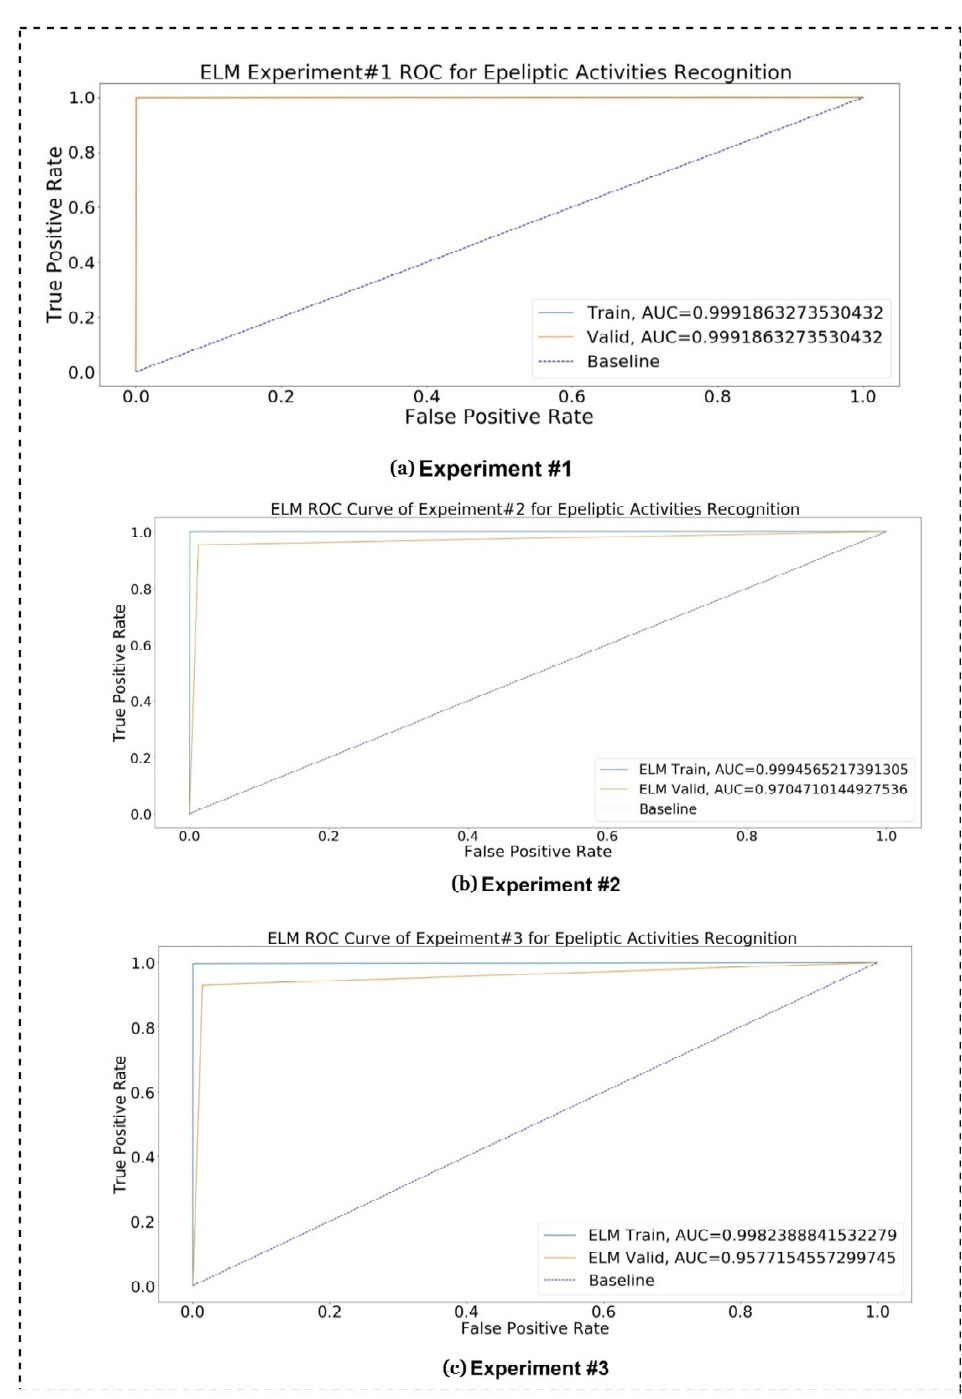
Figure 8. ROC Curves of ( a ) Experiment #1; ( b ) Experiment #2; ( c ) Experiment